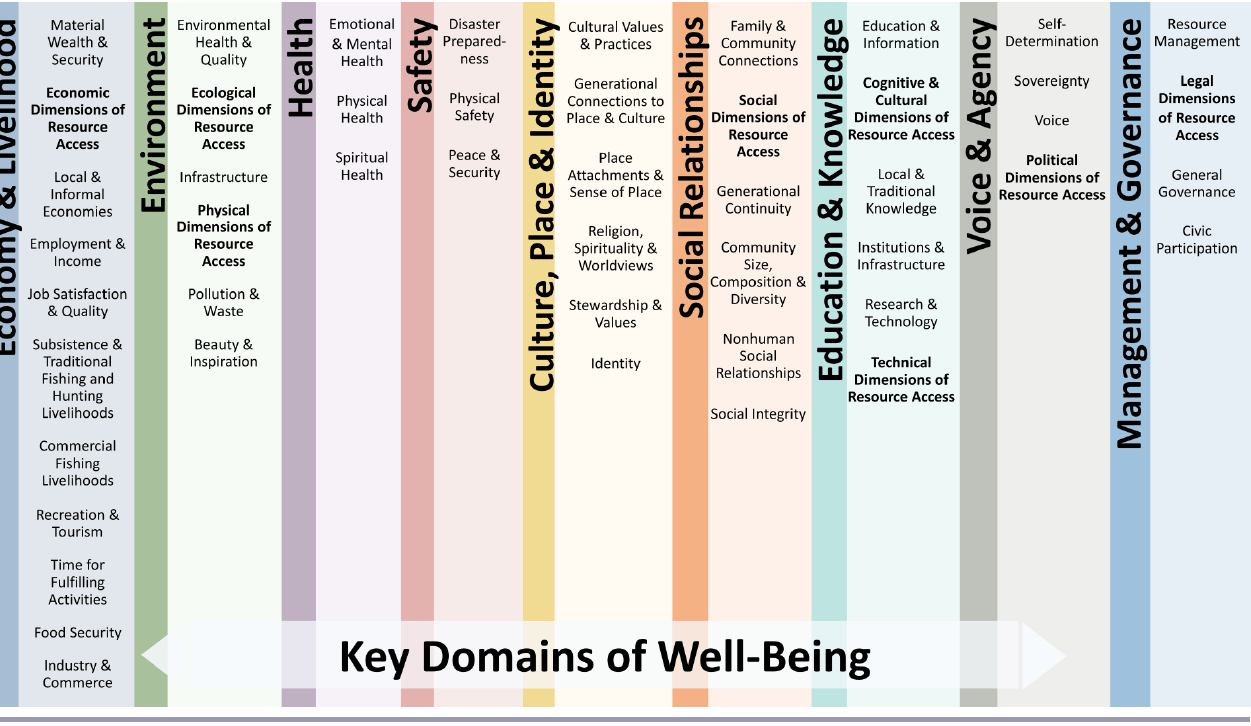
Fig. 2 . State of Alaska’s Salmon and People well-being domains and